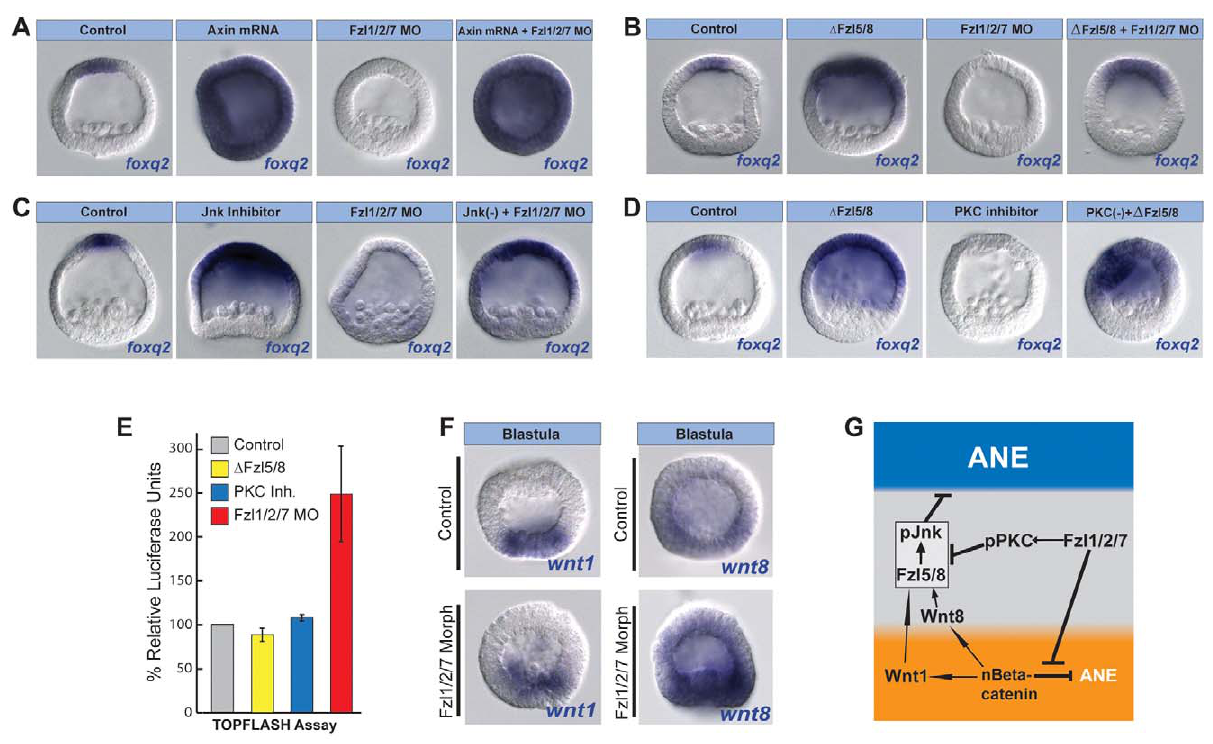
Figure 5. Fzl1/2/7 signaling and PKC activity antagonize the ANE restriction mechanism. (A–D) Injected molecules are indicated above each panel. Inhibition of Fzl1/2/7 function (Fzl1/2/7 MO) does not interfere with foxq2 expression in the absence of n b -catenin (Axin mRNA) (A) or functional Fzl5/8 ( D Fzl5/8 mRNA) (B) or when JNK was inhibited (C). (D) Blocking PKC activity in the absence of D Fzl5/8 signaling rescues foxq2 expression. (E) TopFlash assays on three different cultures of embryos showing that the activity of Fzl1/2/7, but not those of Fzl5/8 or PKC, suppress n b -catenin activity. (F) wnt1 and wnt8 are expressed in the endomesoderm of Fzl1/2/7 morphants. (G) Diagram showing a model for ANE restriction based on the data presented in this and the preceding figures. MO,